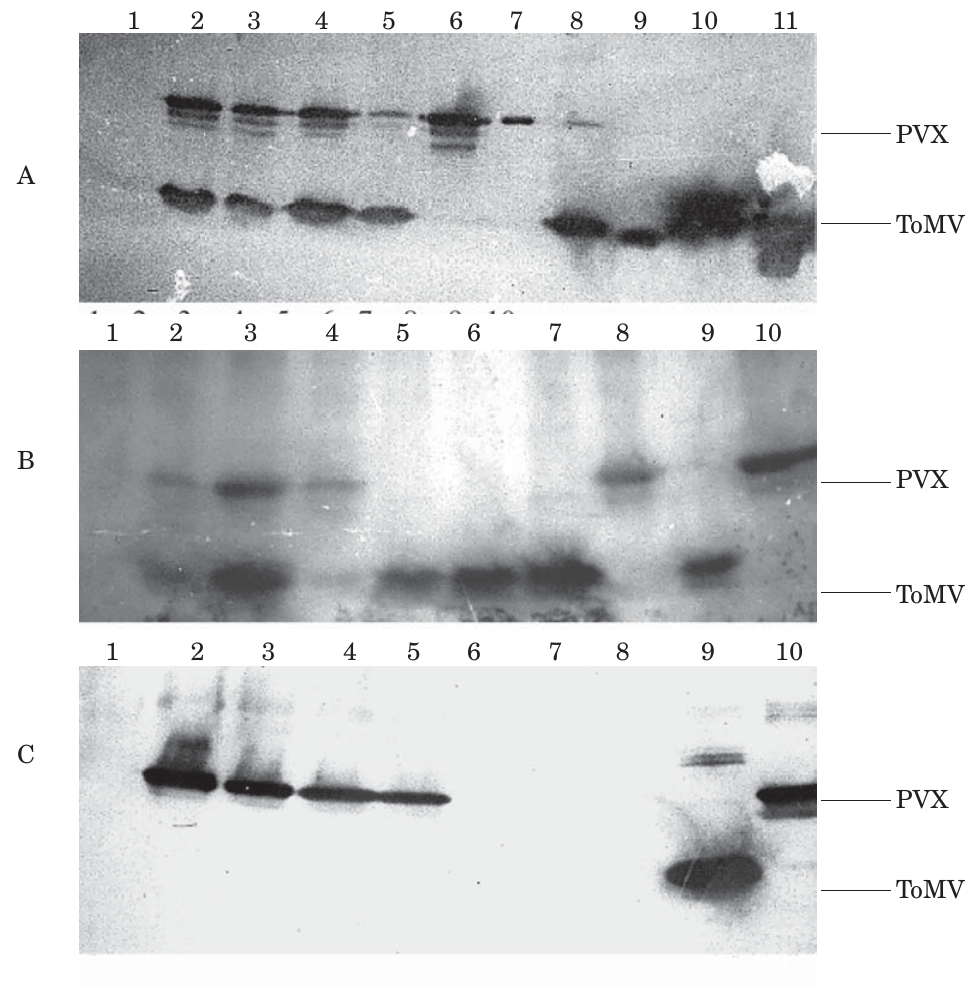
Fig. 2. Western blot analysis of accumulated viral coat proteins in the inoculated leaf of different tomato cultivars under single or mixed infection with PVX and different strains of TMV. (A) Fukuju No. 2 at 5 dpi. Lane 1, control; 2, P+L+ L11A; 3, P+L; 4, P+L11A; and 5, P+OM. Lane 6, PVX (P) alone; 7, purified PVX; 8, L11A alone; 9, OM alone; 10, L alone and 11, purified ToMV-L. (B) GCR 236 at 7 dpi. Lane 1, control; 2, P+ L11A; 3, P+L; and 4, P+OM. Lane 5, OM alone; 6, L11A alone; 7, L alone; 8, P alone; 9, purified TMV-L and 10, purified PVX. (C) GCR 237 at 7 dpi. Lane 1, control; 2, P alone; 3, P+L; 4, P+L11A; 5, P+ OM; 6, L11A alone; 7, OM alone; 8, L alone; 9, purified ToMV-L and 10, purified PVX. All bands were visualized using combinations of polyclonal antibodies raised against the individual viruses in rabbits. The position of the PVX and ToMV bands are as